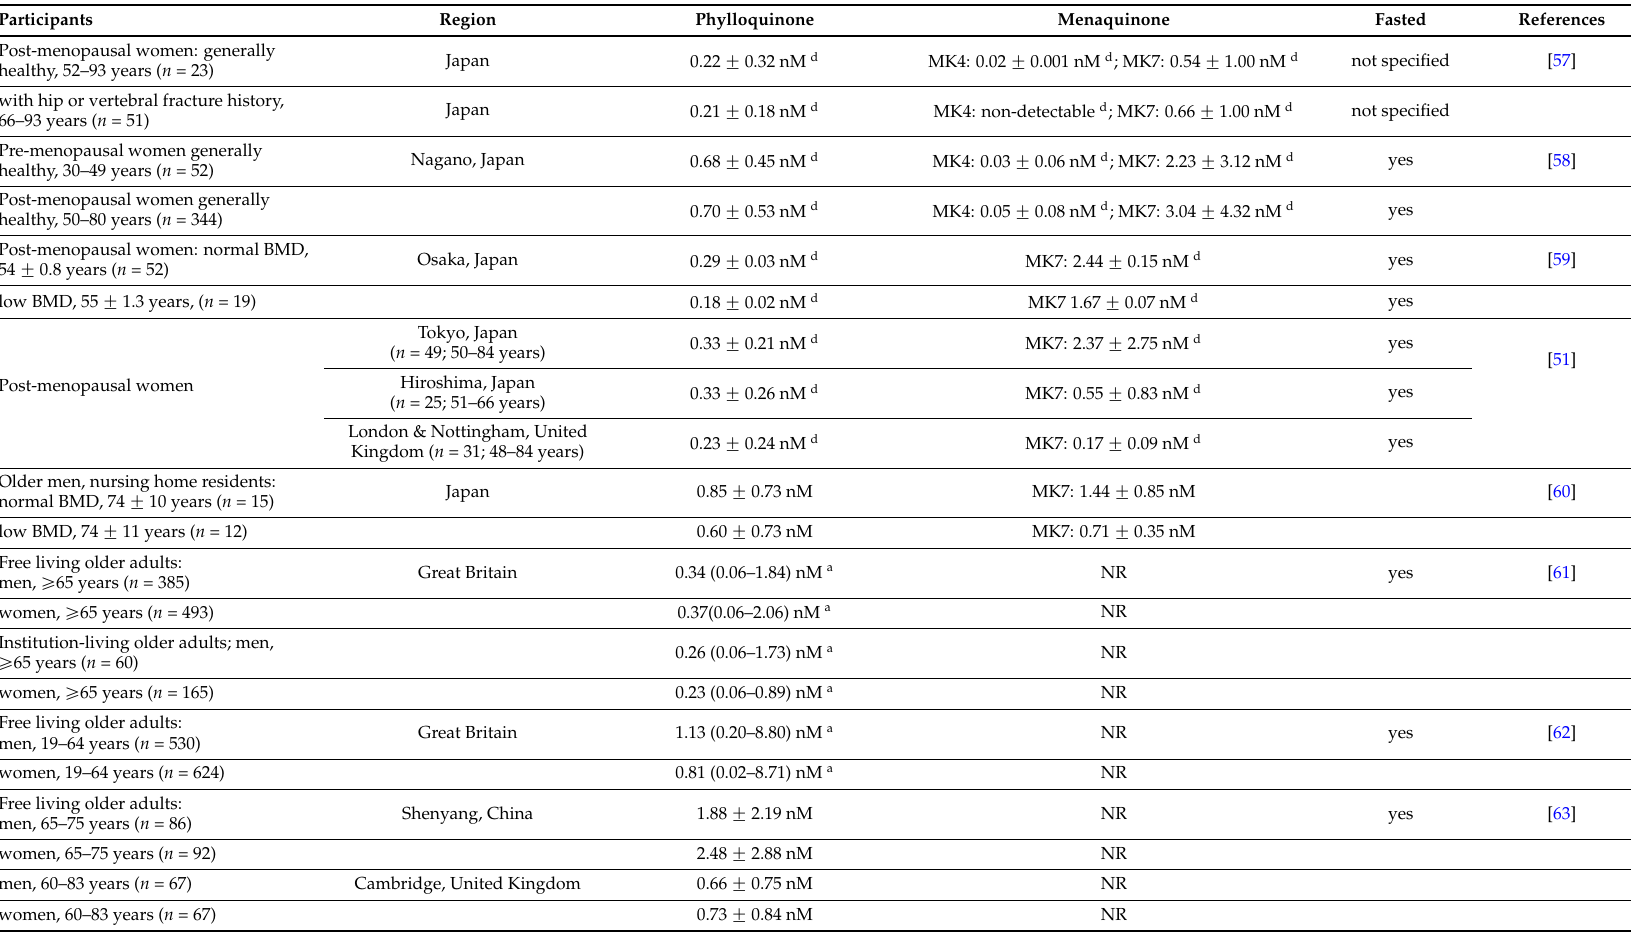
Table 2. Reported circulating concentrations of vitamin K in population- or clinic-based individuals not taking vitamin K supplements (Data are mean ˘ SD, unless otherwise